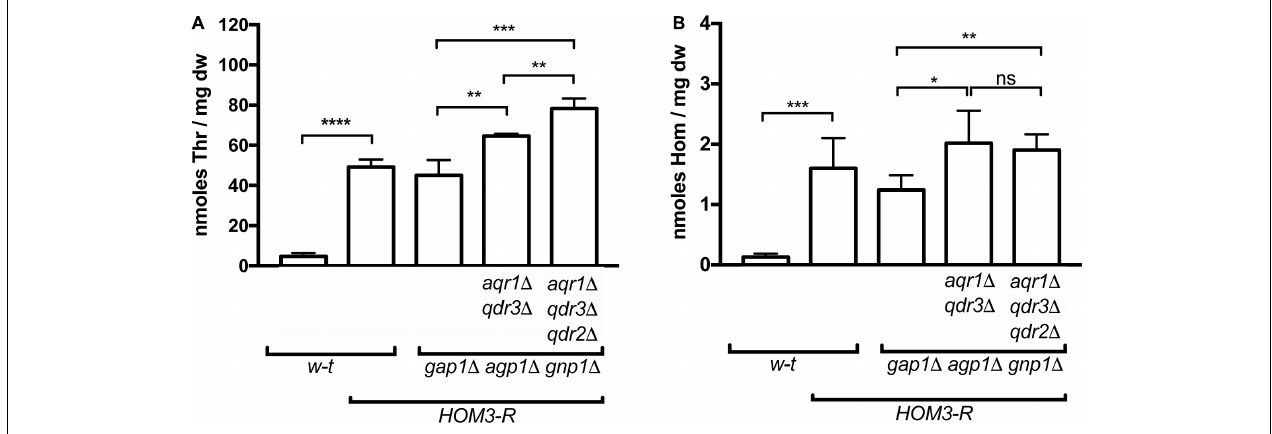
FIGURE 1 | Overproduction of threonine and homoserine in yeast strains used in cross-feeding assays. Intracellular concentrations of threonine (Thr) (A) and homoserine (Hom) (B) were quantified by UPLC in wild-type and mutant strains (genotypes indicated), transformed with plasmid pGK007 ( HOM3-R ) or the empty vector. Cells were grown in a minimal glucose medium with glutamate as sole nitrogen source. Bars represent averages of four independent experiments ± standard deviation. * indicates a statistically significant difference as determined with the unpaired t- test. * P < 0.0332; ** P < 0.0021; *** P < 0.0002; and **** P < 0.0001. ns, not significant, P >